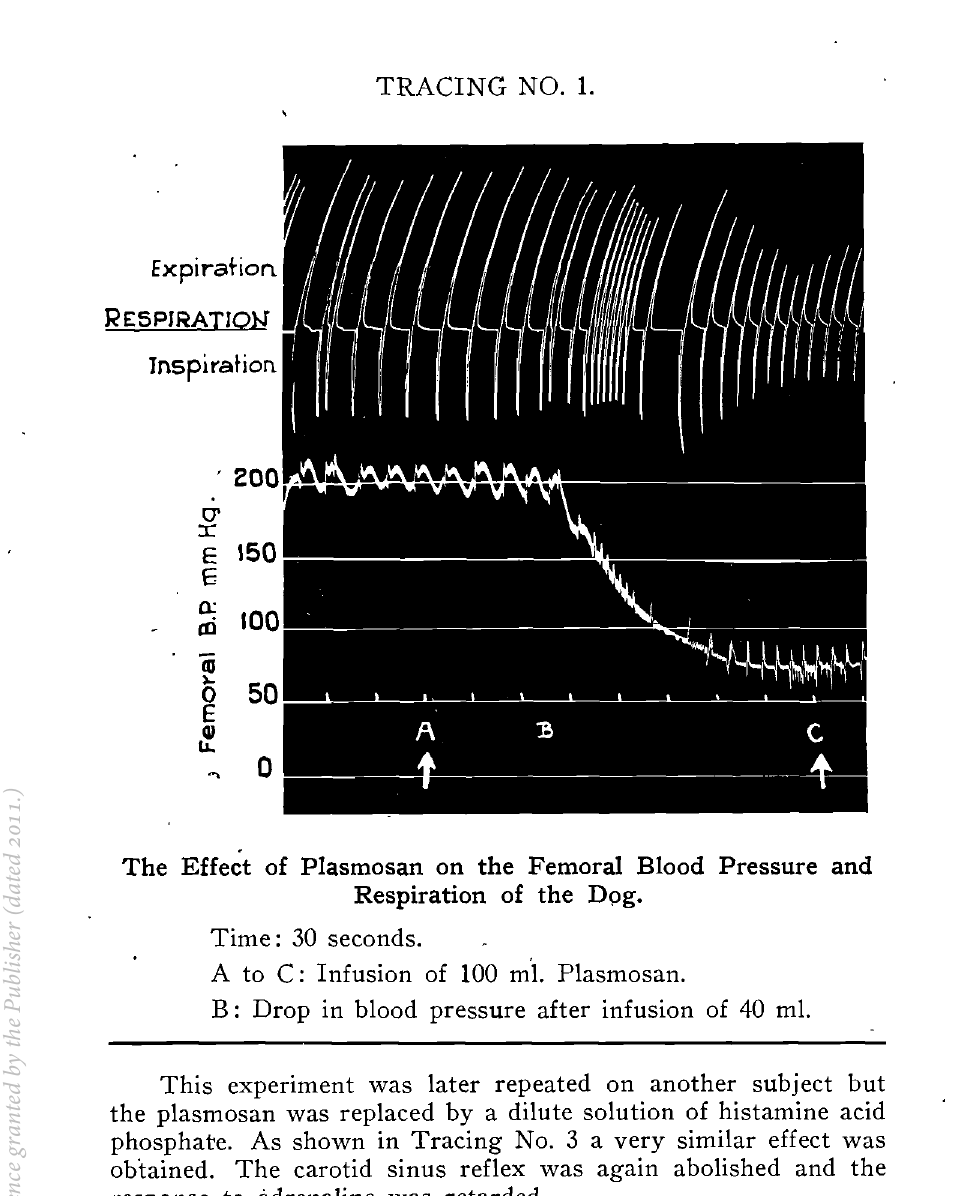
The Effect of Plasmosan on the Femoral Blood Pressure and Respiration of the